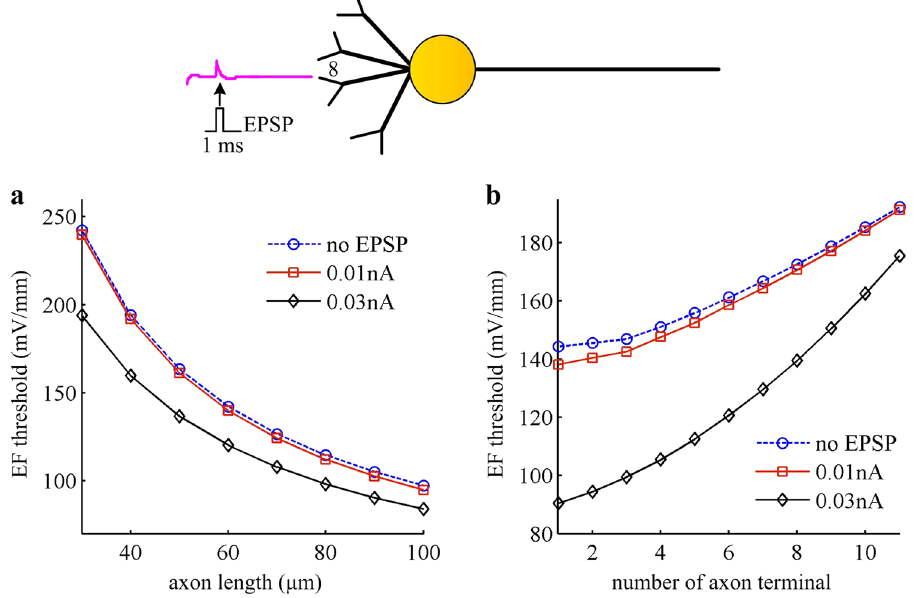
Figure 7. Introducing EPSP reduces EF firing threshold in artificial model. The EPSP is modeled as a weak current pulse I , and it is introduced to No. 8 distal dendrite. The relevant amplitude of I EPSP and 0.03 nA. (a) and (b) respectively shows the EF firing threshold as a function of axon length and its terminal number in the cases of = I 0nA (i.e., no EPSP), 0.01 nA, and 0.03 EPSP